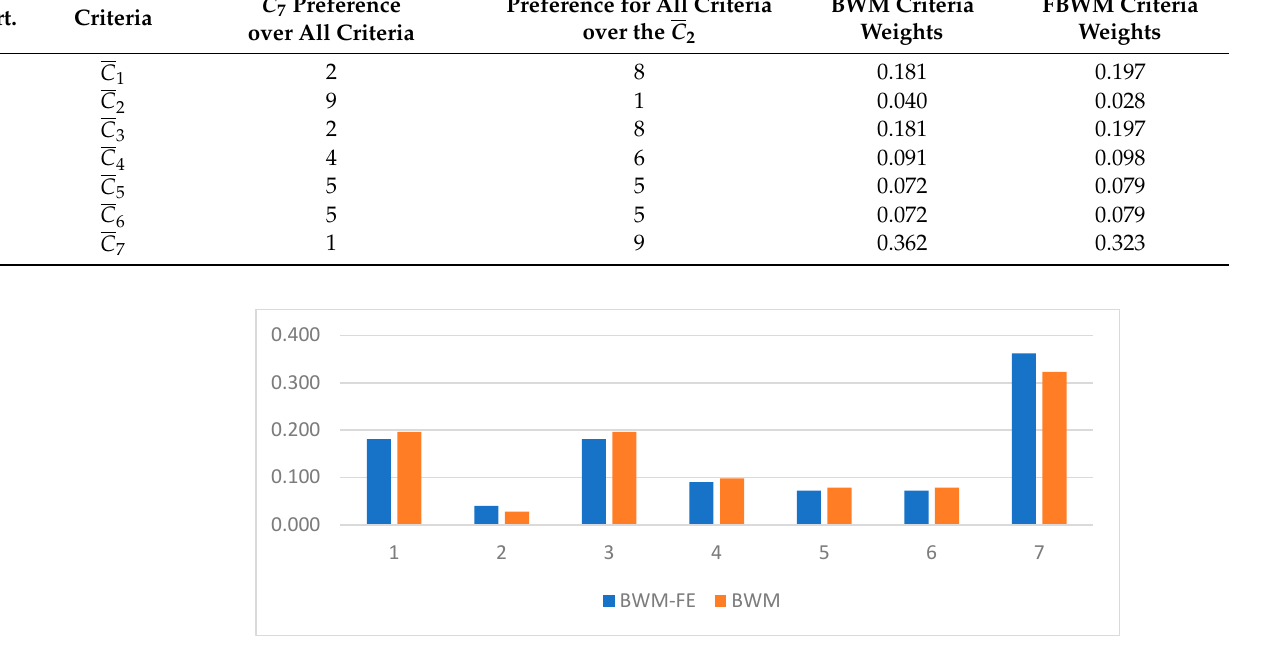
Table 4. Comparison between the brand criteria weights obtained using BWM and FBWM. Nr.crt.